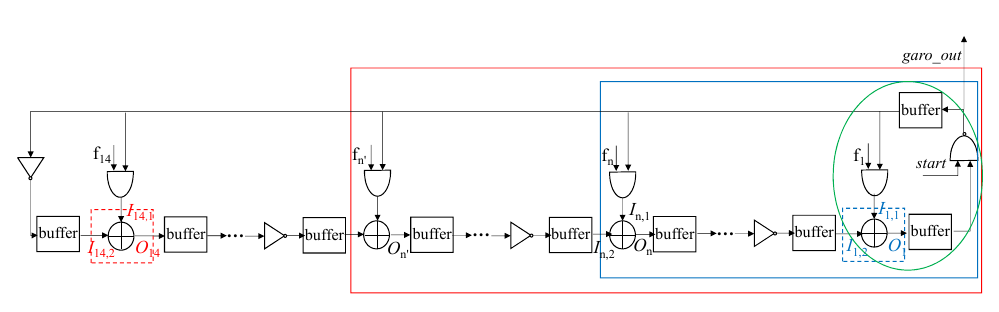
Figure 12: The circuit structure of the gate-level